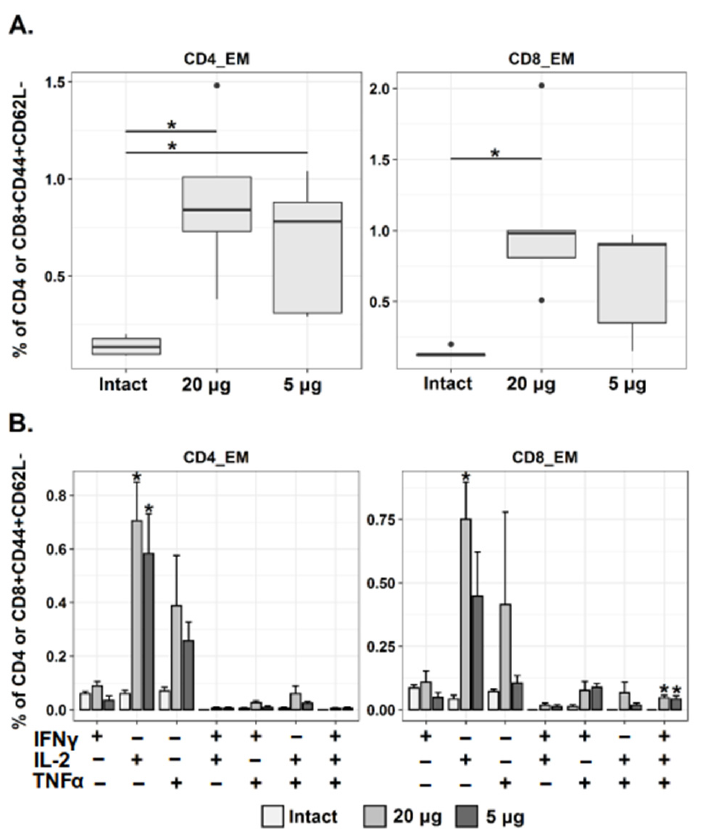
Figure 6. Analysis of SARS-CoV-2-specific CD4+ and CD8+ Tem responses following Betuvax-CoV-2 vaccination. Mice were immunized ip twice with Betuvax-CoV-2 (5 and 20 µ g of antigen). ( A ) Percentage of virus-specific CD4+ and CD8+ Tem among CD4+/CD8+CD44+CD62L − splenocytes; points indicate individual outlier values; ( B ) Relative frequency of virus-specific cytokine-producing CD4+ and CD8+ Tem. The bar-plots represent the average percentage of each cytokine-producing population (IFN γ + IL-2 − TNF α − , IFN γ − IL-2+ TNF α − , IFN γ − IL-2 − TNF α +, IFN γ + IL-2+ TNF α − , etc.) within the total CD4 or CD8 Tem cell subset (Mean ± SE) after 6 h of stimulation with SARS-CoV-2 spike protein peptide pool; * p < 0.05.